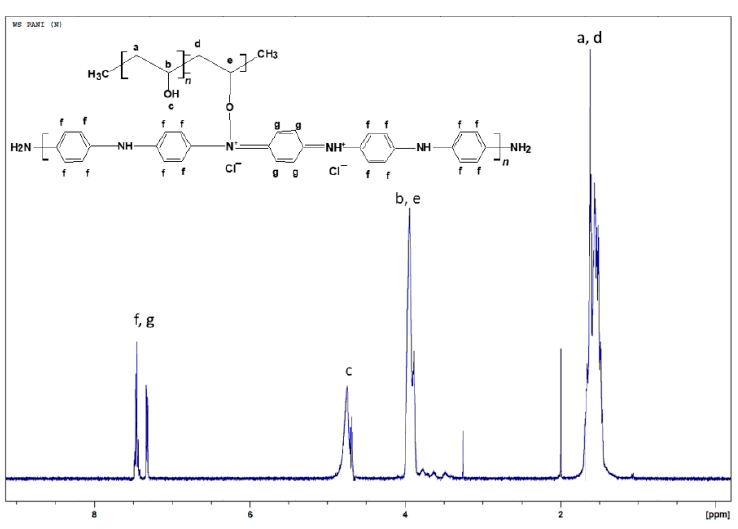
Figure 2. 1 H-NMR spectra for PVA–PANI with water suppression.